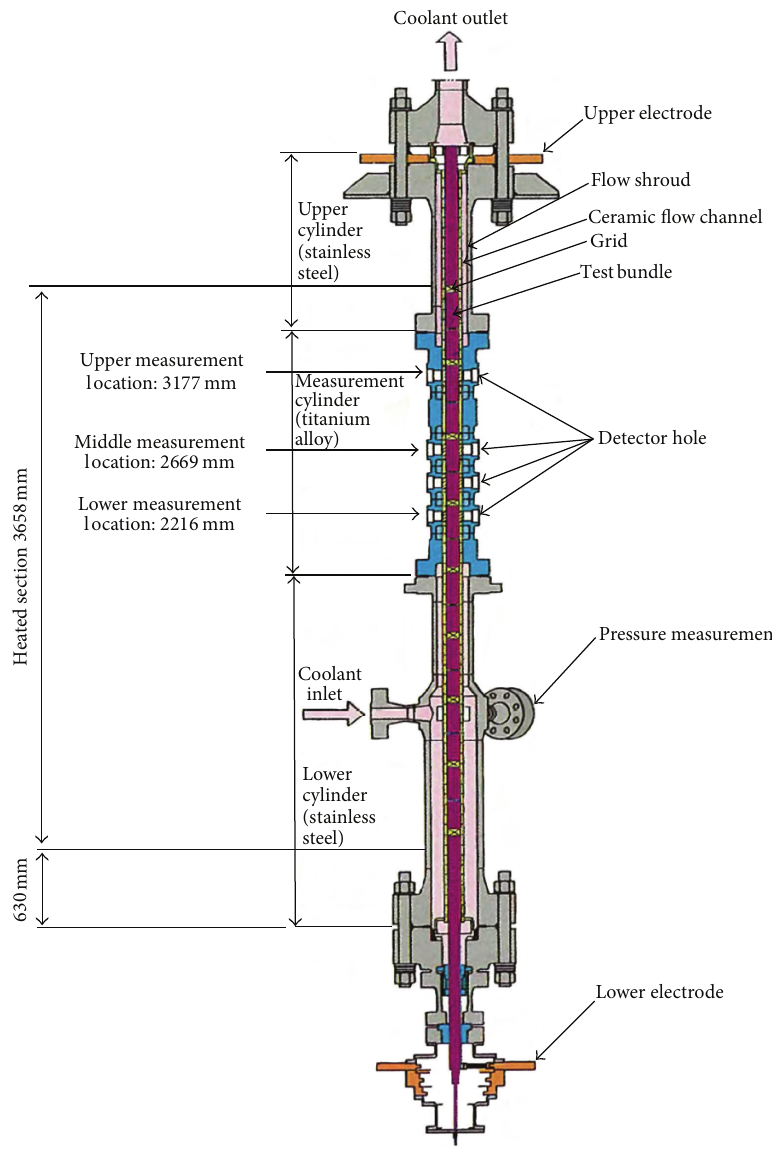
Figure 4: Test section for rod bundle void distribution